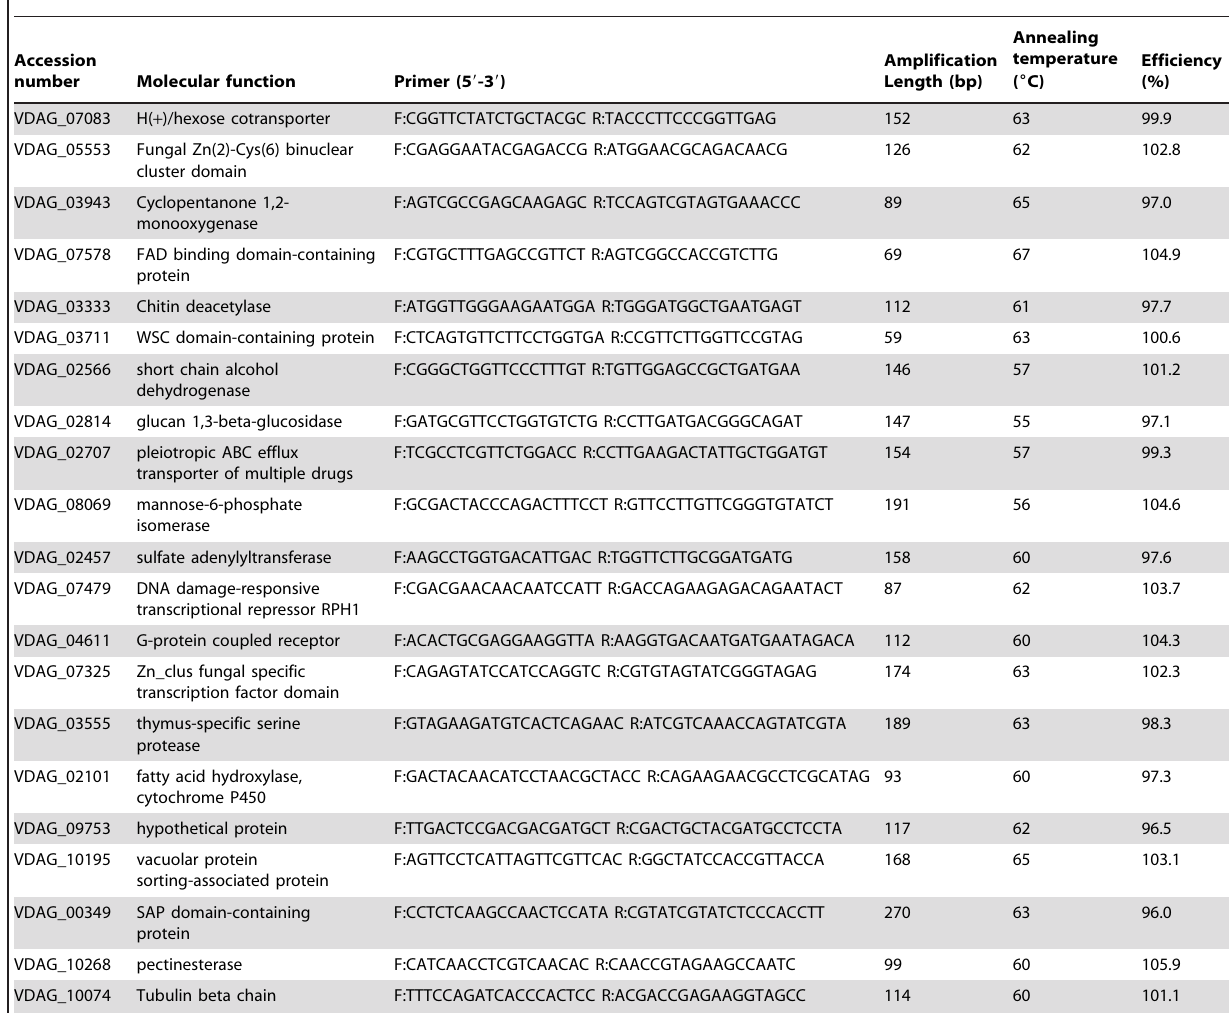
Table 2. Primers for qRT-PCR quantification of 20 randomly selected genes from the 40 most differentially expressed genes that were up-regulated or down-regulated in the germinated Verticillium dahliae microsclerotia (VDMG-b) compared to the non- germinated Verticillium dahliae microsclerotia